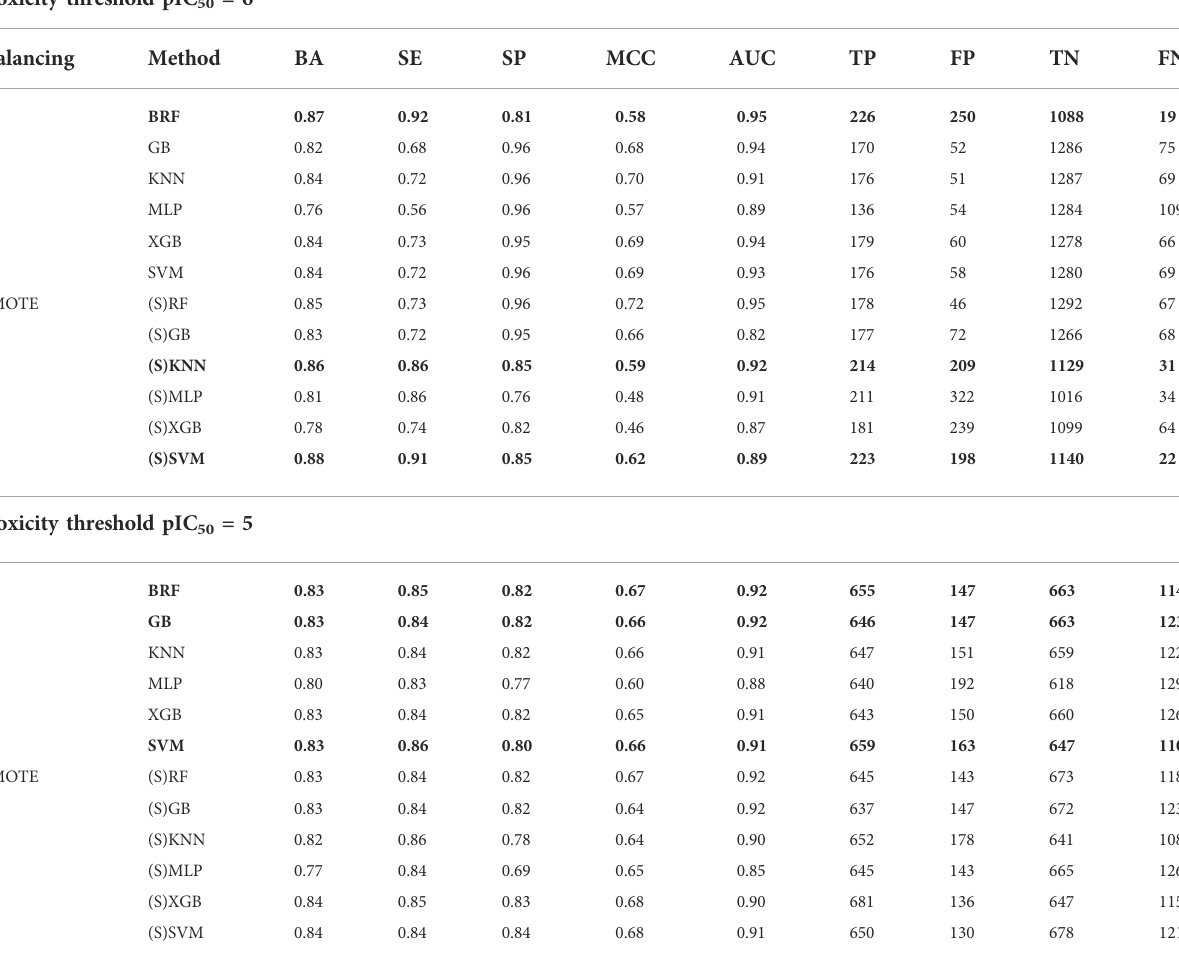
TABLE 2 Performanceson the VS ofthe models developed using pIC 50 = 6(top) and 5 (bottom).For each model, the followingstatisticsare reported: balanced accuracy (BA), sensitivity (SE), speci fi city (SP), Matthews correlation coef fi cient (MCC), area under the ROC (AUC), number of true negatives (TNs), false positives (FPs), true positives (TPs), and false negatives (FNs). The top-performing model selected for additional validation is indicated in